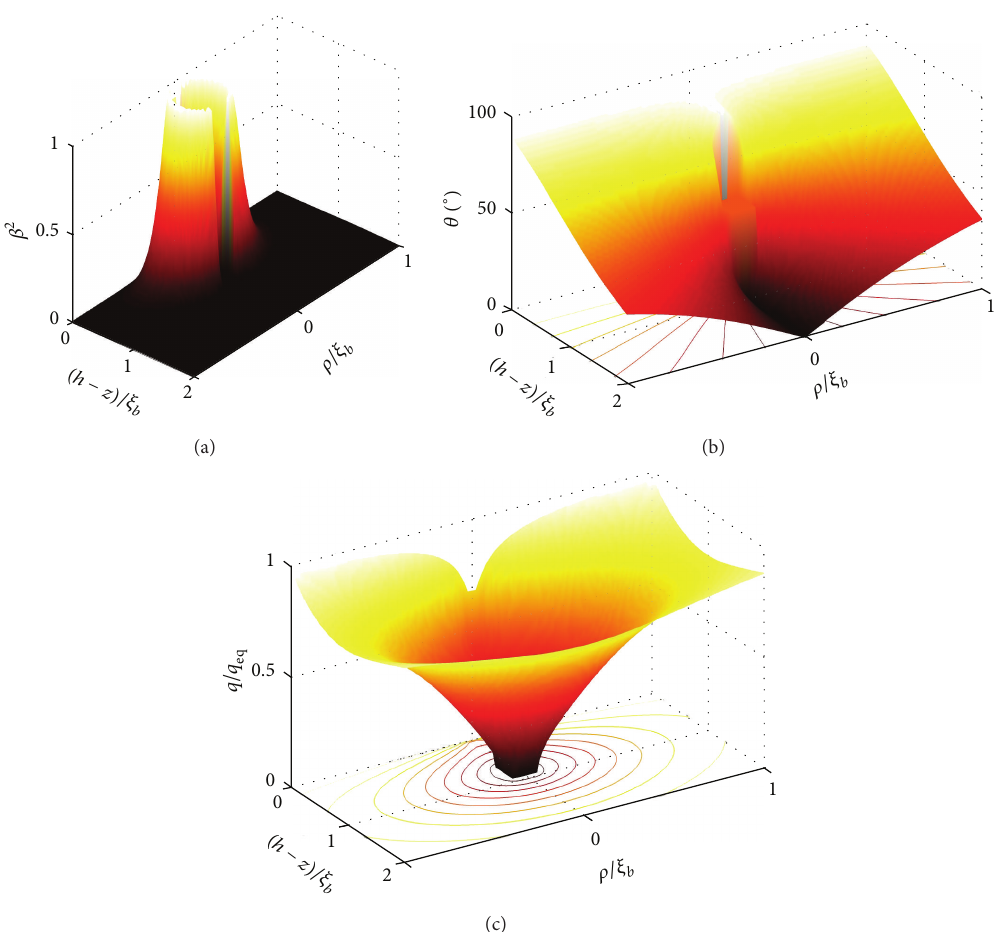
Figure 3: Two-dimensional plots showing degree of nematic ordering within the {𝜌,𝑧} plane for a given position of a NP enforcing melted boundary condition. (a) 𝛽 2 (𝜌,𝑧) , (b) 𝜃(𝜌,𝑧) , and (c) 𝑞(𝜌,𝑧) = √ Tr Q 2 , where 𝑞 = 10 ℎ/𝜉 (0) 𝑏